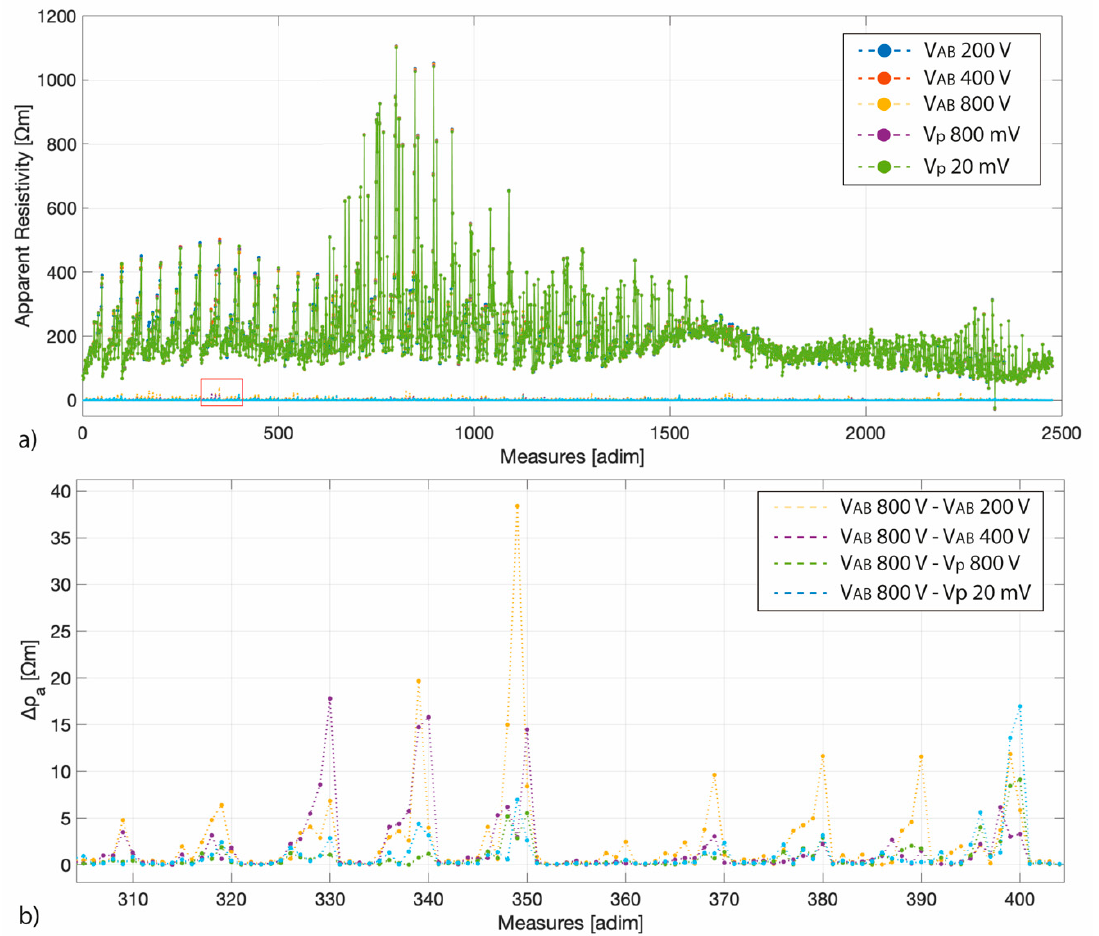
Figure 9. The DD and PD level anomaly effect (lAE) for the original and simulated (25th percentile, 75th percentile, maximum, mean, median, and minimum) datasets obtained with an input voltage of 200 V.